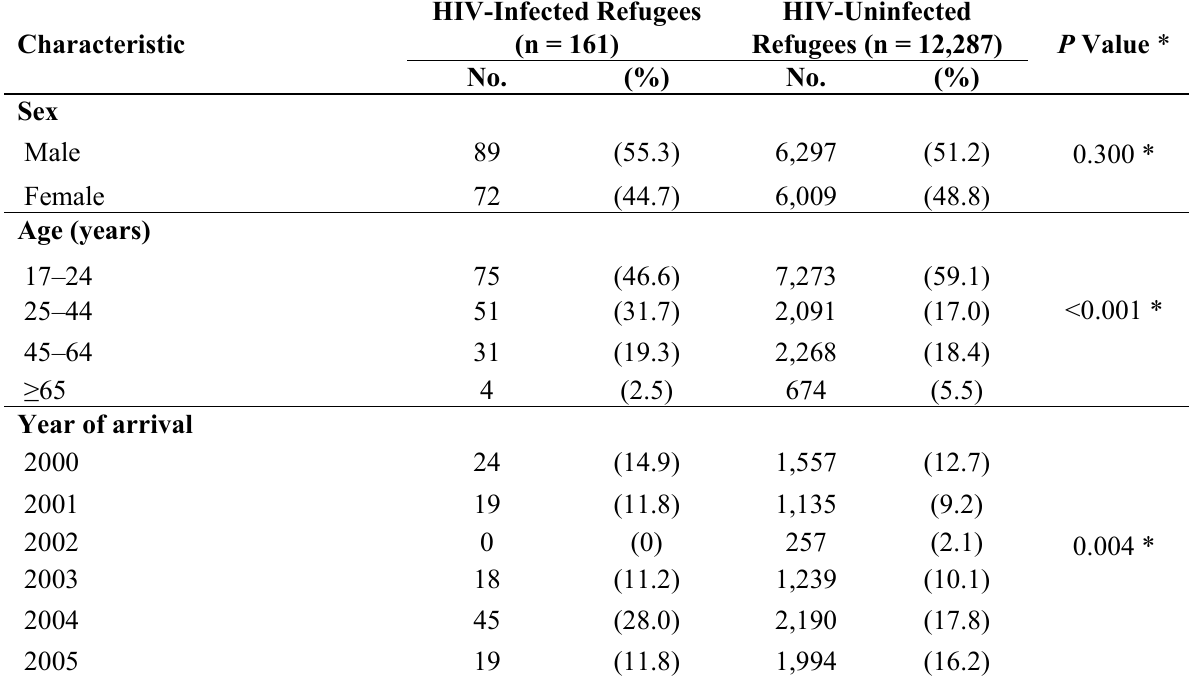
Table 3. Demographics and Coinfections Identified during Routine Refugee Health Screening Assessment Comparing HIV-Infected to HIV-Uninfected Refugees from Sub-Saharan Africa Resettled to Minnesota during